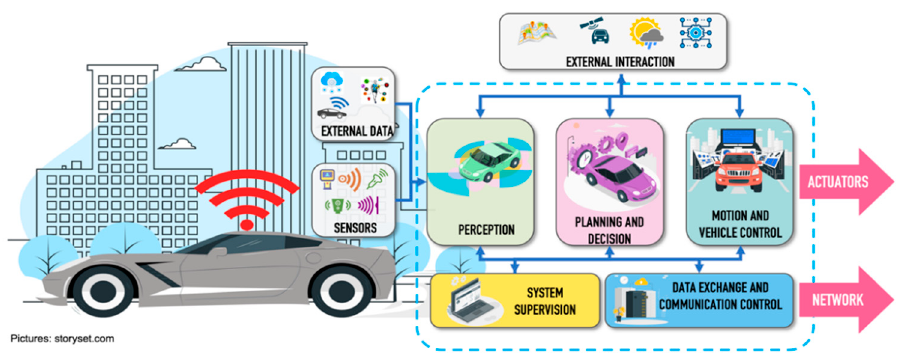
Figure 3. Representation of the functional architecture for a connected autonomous vehicle [8].